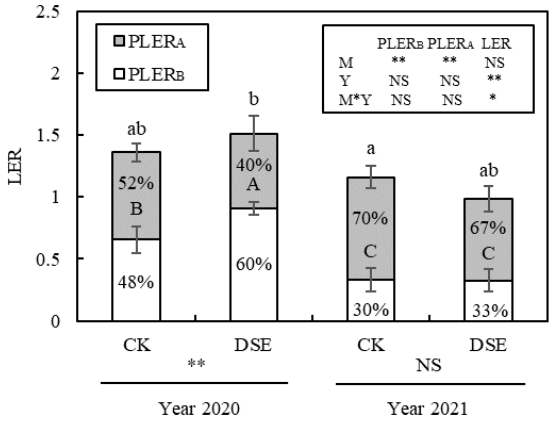
Figure 7. Land equivalent ratio (LER) of the buckwheat-alfalfa intercropping system under different microbial treatments. Different lowercase letters indicate a significant difference at the 5% level by LSD between different treatments in 2020. Different capital letters indicate a significant difference at the 5% level by LSD between different treatments in 2021. M, microbial treatment; Y, year; *, p < 0.05; **, p < 0.01; NS, not significant.